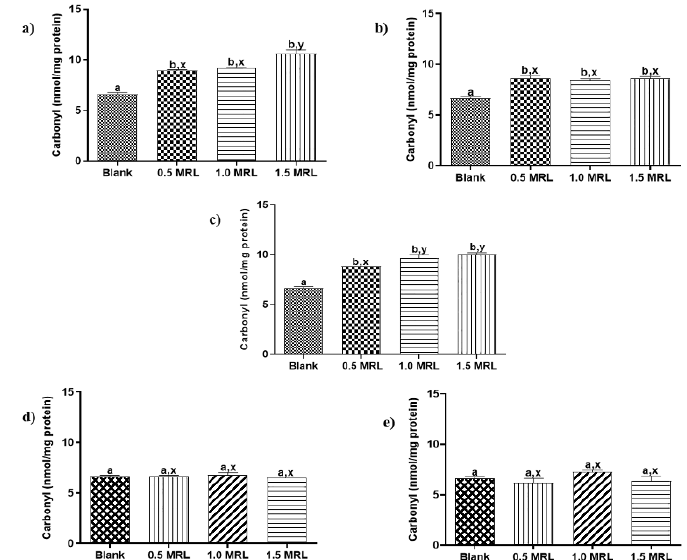
Figure 3. Changes in carbonyl content of myofibrillar proteins induced by ( a ) enrofloxacin ( b ) danofloxacin, ( c ) sarafloxacin, ( d ) ciprofloxacin y ( e ) norfloxacin. Mean values ± SEM. Superscripts a – b and x-y show significant statistical differences between means of groups ( p < 0.05 ): a – b show differences with respect to blank, while x-y differences between FQ concentrations. 3.2. Yielding of Protein Fractions is A ff ected by Protein Oxidation Induced by